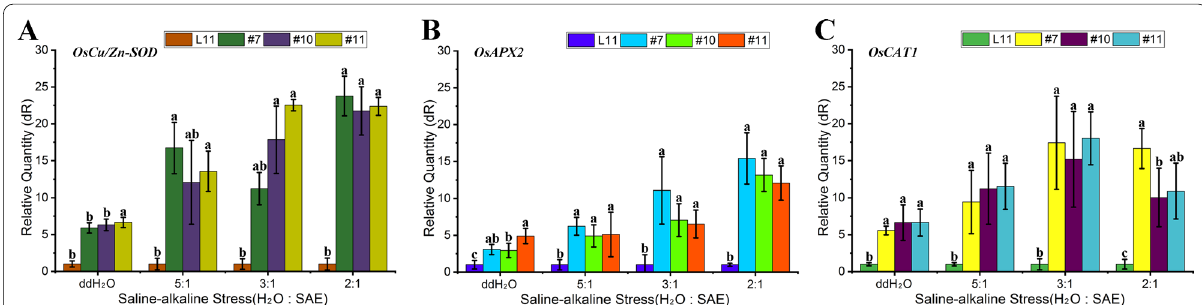
Fig. 5 Expression of OsCu / Zn-SOD , OsAPX2 , and OsCAT1 in OsSAP6 overexpression rice under soda saline–alkaline stress. 4-week-old OsSAP6 overexpression lines and Lj11 seedlings were treated with different ratios of SAE (H 2 O:SAE expression levels of OsCu/Zn-SOD ( A ), OsAPX2 ( B ), and OsCAT1 ( C ) were detected by qRT–PCR. The expression level of Lj11 was set to 1, and the